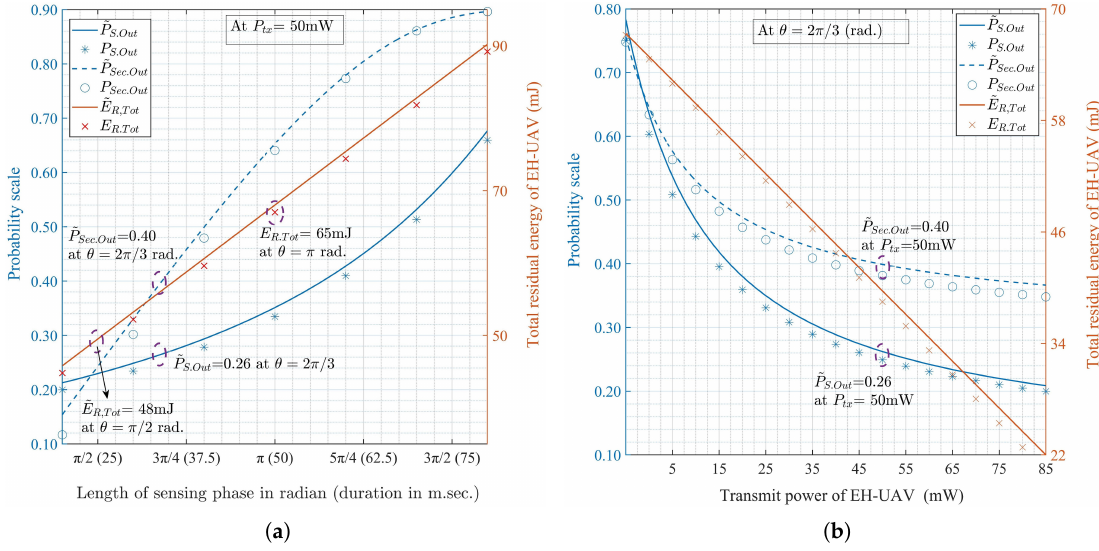
Figure 2. Total residual energy, connection and secrecy outage probabilities, and their approximation under perfect sensing with respect to ( a ) length of sensing phase (duration) with a fixed transmit power, ( b ) transmit power for a fixed length of sensing